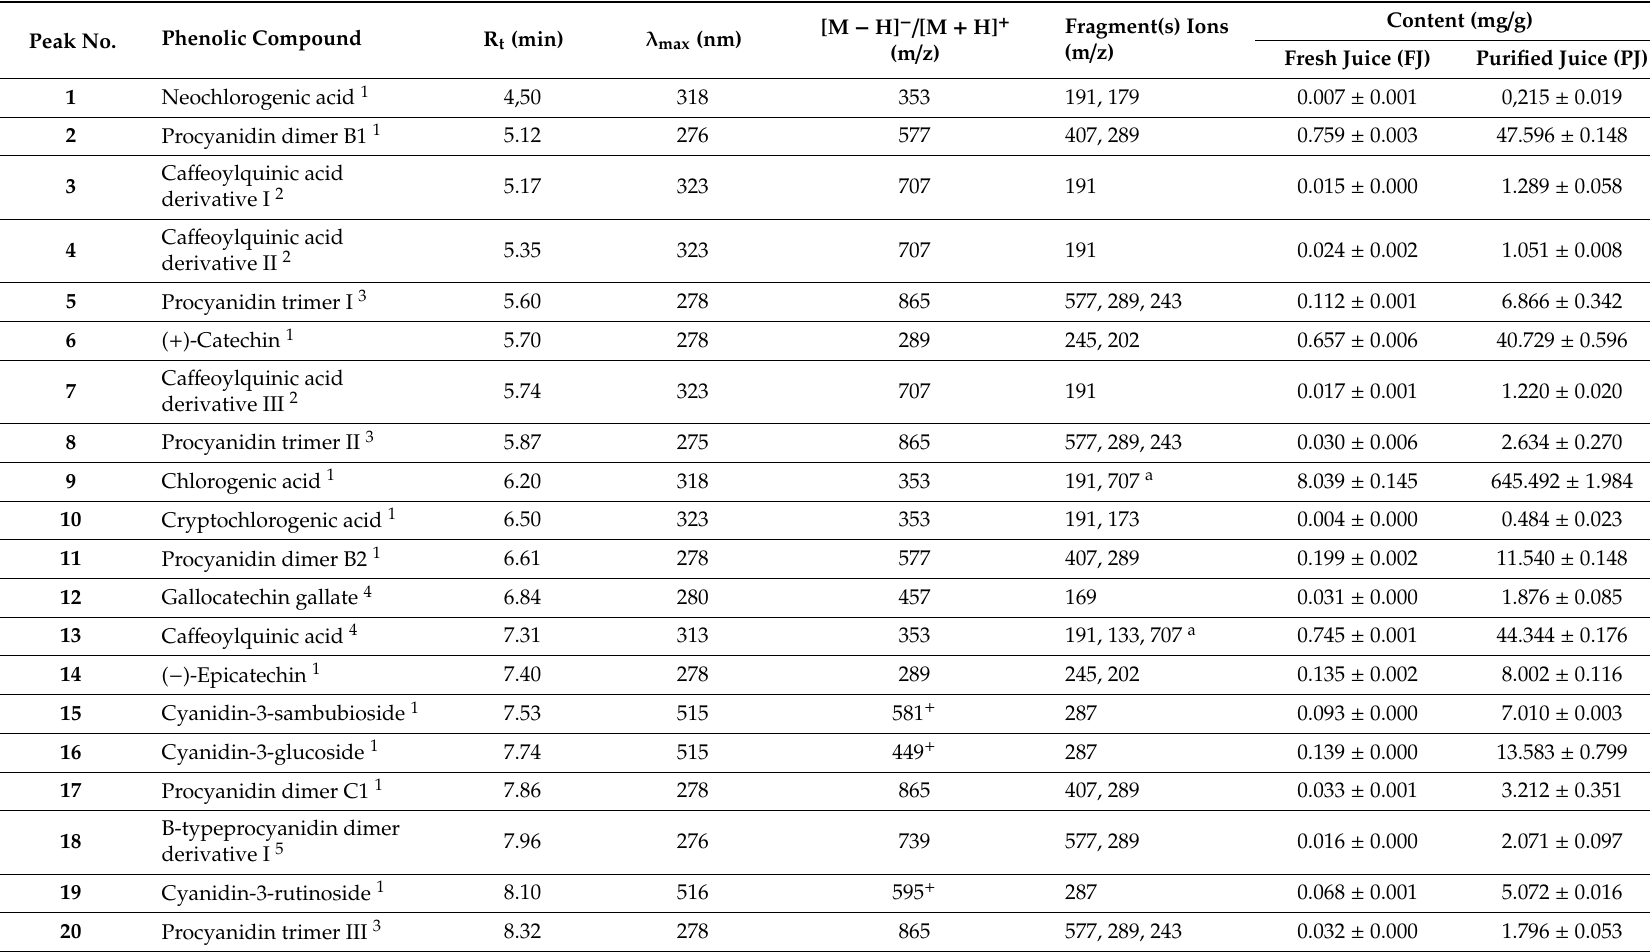
Table 1. Retention time (Rt), wavelengths of maximum absorption ( λ max), mass spectral data, and the identification and quantification of phenolic compounds in fresh juice and purified juice of Viburnum opulus